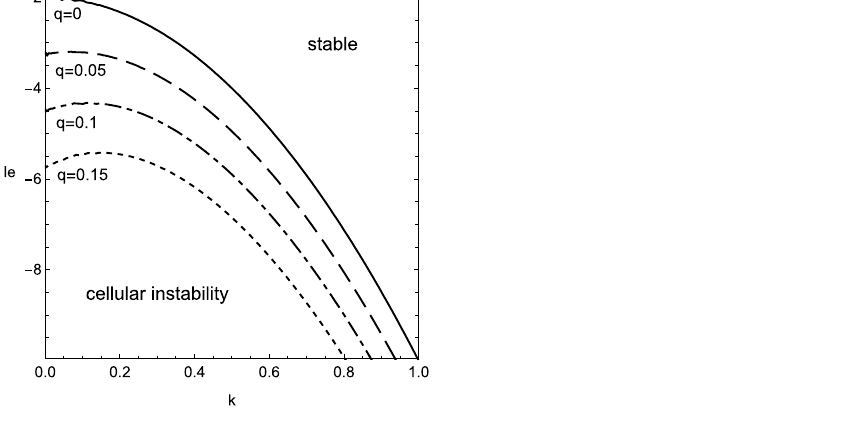
Figure 1. Stability boundary of cellular instability for several values of heat release, q (dashed), 0.1 (dot-dashed) and 0.15 (dotted), with β